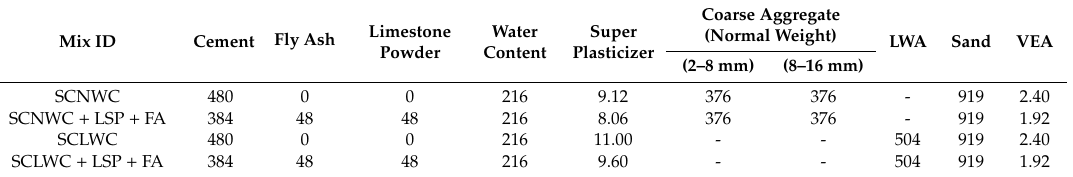
Table 3. Concrete mix proportions (kg / m 3 ). SCNWC, self-consolidating normal weight concrete; SCLWC, self-consolidating lightweight